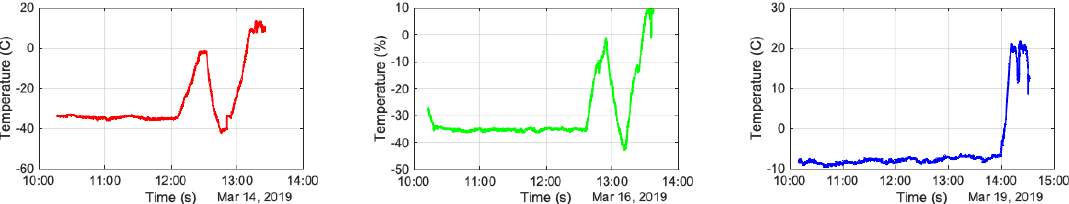
Figure A2. The atmospheric pressure on each observation day during flight.